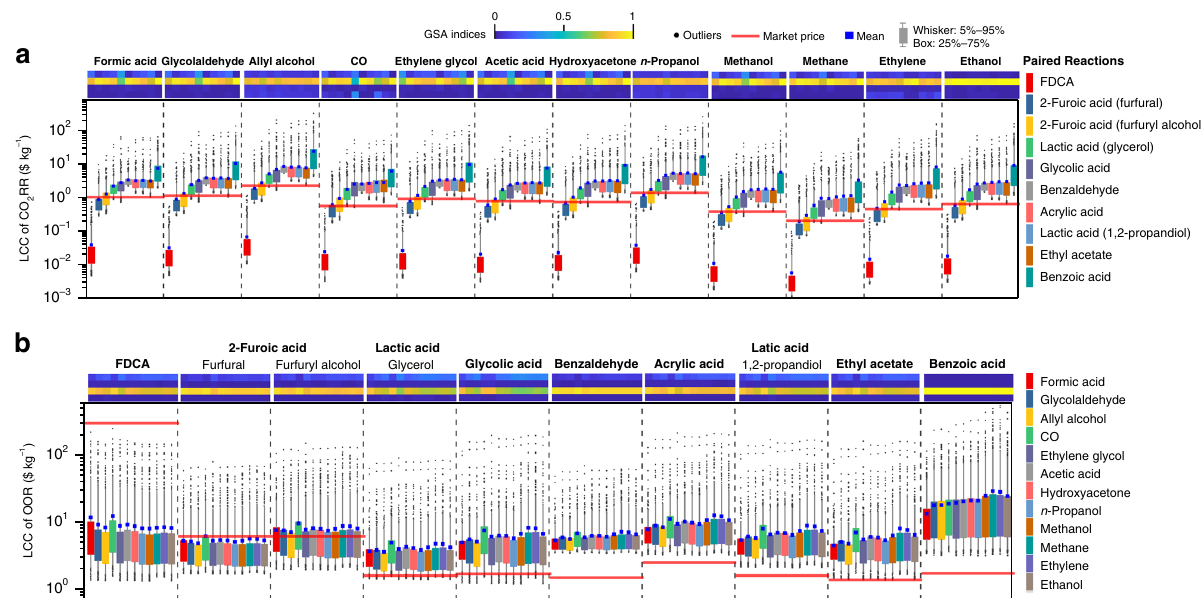
Fig. 6 Distribution of levelized cost of chemicals with respect to coproduction strategy. a LCCs of CO 2 RR products paired with 10 different OOR processes. b LCCs of OOR products paired with eight different CO 2 RR